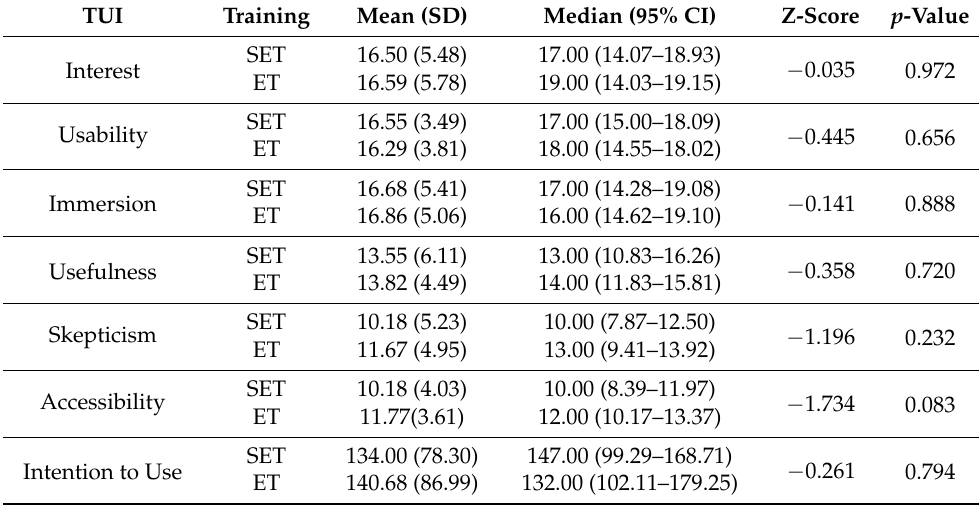
Table 1. Results of the Technology Usage Inventory (TUI) for the strength endurance training (SET) and endurance training